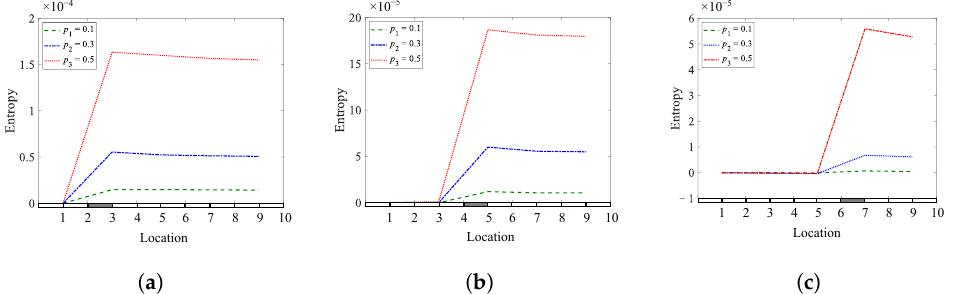
Figure 25. The effect of reducing the number of measurement points (5 points) on damage localization using Shannon entropy at various crack depths and locations: ( a ) q 1 = 0.25; ( b ) q 2 = 0.45; ( c ) q 3 =